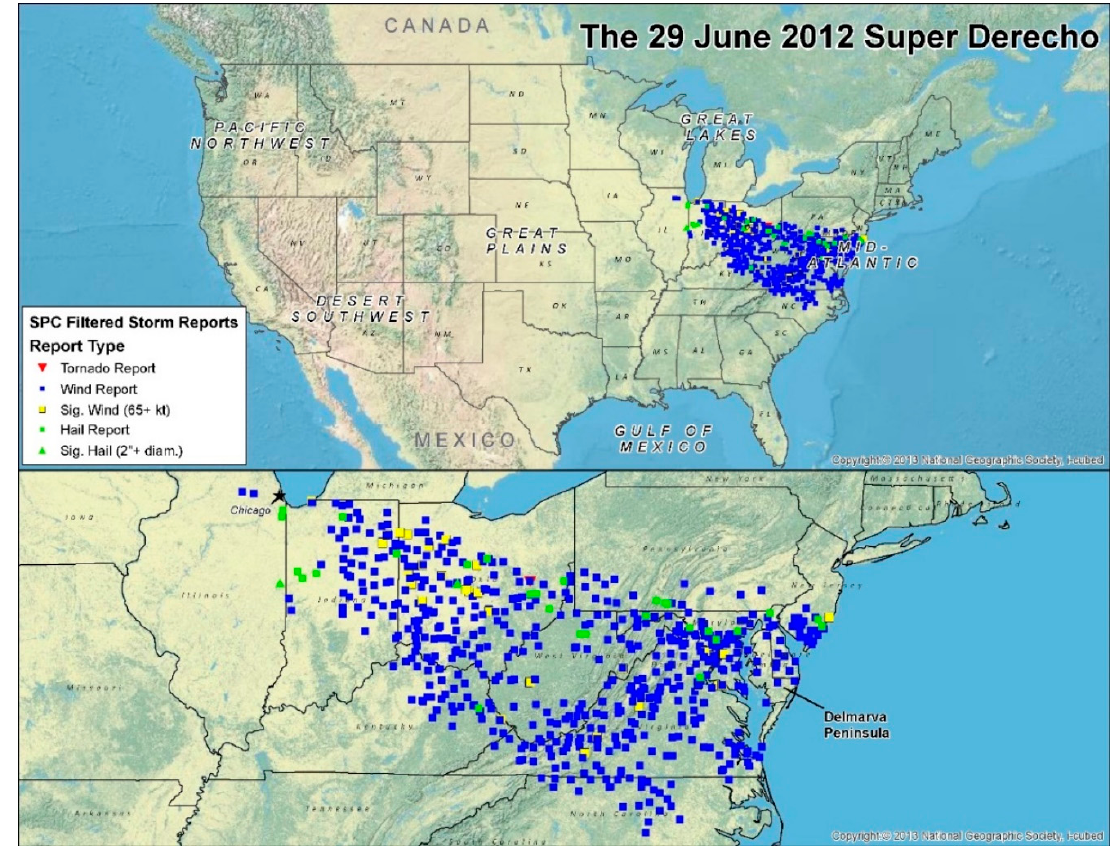
Figure 1. SPC Filtered Storm Reports overlayed on a topographic map of the United States with key geographical features mentioned throughout this study annotated.